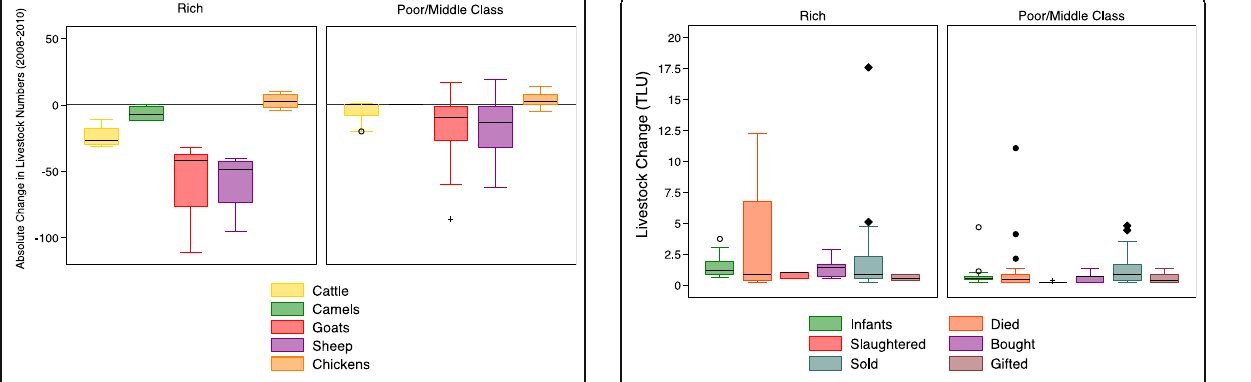
Figure 20 Factors facilitating changes in absolute number of livestock among different social strata. Significant differences exist between rich and poor/middle class families regarding changes to total livestock values under categories such as births, purchases, and